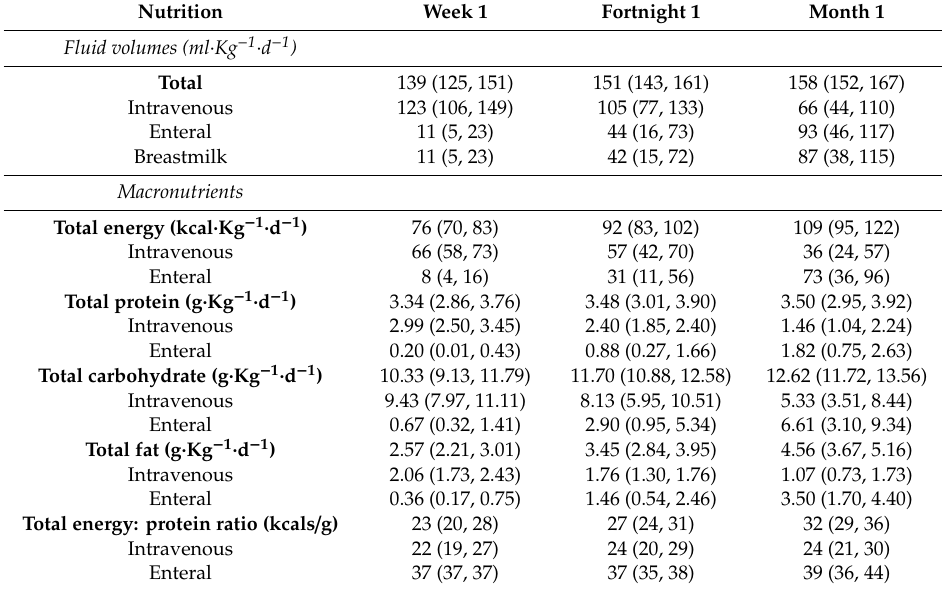
Figure 5. Percentage of babies at each site with expected growth from birth 36 weeks’ corrected age. ( A ) weight ( n = 369), ( B ) length ( n = 346), ( C ) head circumference ( n = 339) and ( D ) target growth ( n = 335). Expected growth is change in z-score from − 0.8 to 0.8, target growth is change in z-score from − 0.8 to 0.8 for all three of weight, length and head circumference. Table 3. Total, intravenous and enteral fluid and macronutrient intakes in the first 4 weeks.